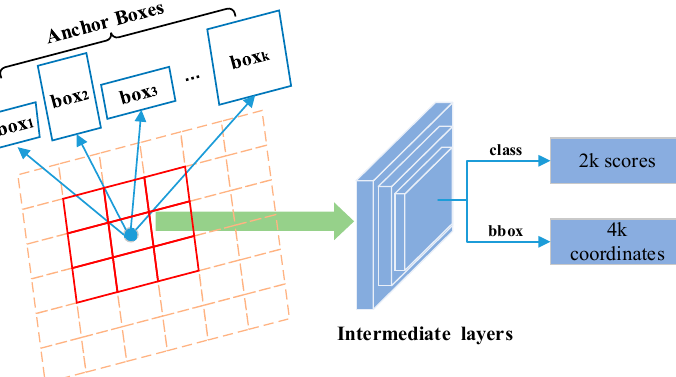
Figure 2. Feature pyramid network FPN.